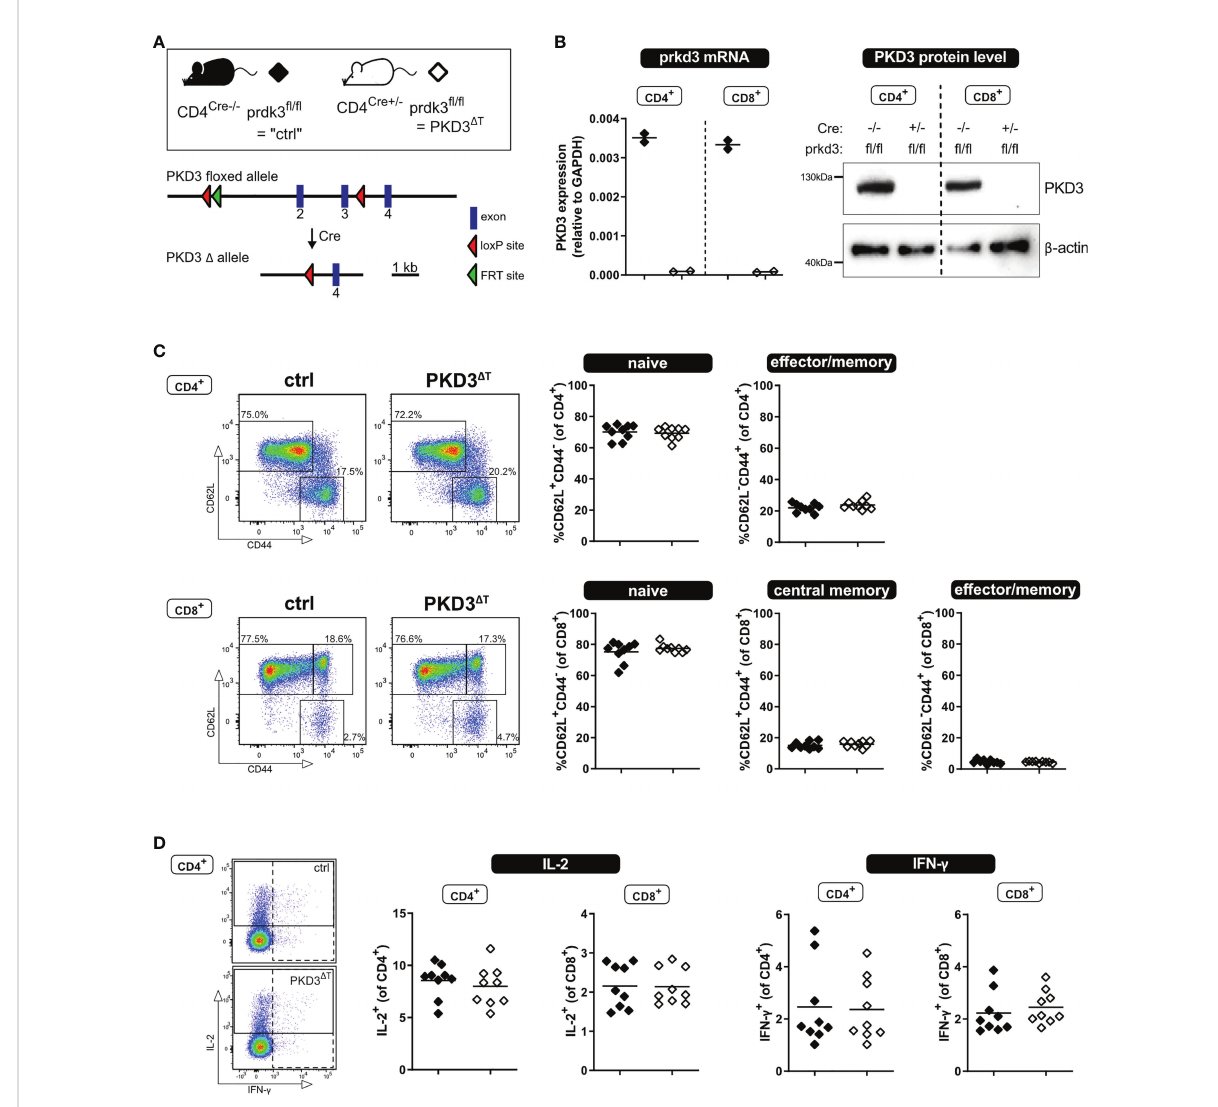
FIGURE 1 T cell-speci fi c PKD3 deletion does not affect the T cell compartment under homeostatic conditions. (A) Scheme of the fl oxed prkd3 locus. (B) Con fi rmation of T cell-speci fi c PKD3-deletion. Ex vivo MACS-sorted CD4 + or CD8 + T cells from spleen and lymph nodes of prkd3- fl oxed mice with or without Cre recombinase were investigated for PKD3 expression on mRNA level by qRT-PCR and on protein level by western blotting. GAPDH and b -actin were used as a house keeping gene or loading control, respectively. (n = 2) (C) Analysis of the splenic T cell compartment of PKD3 D T mice and respective controls by fl ow cytometry. Frequencies of naïve (CD62L + CD44 - ), central memory (CD62L + CD44 + ) and effector/memory (CD62L - CD44 + ) T cells were determined. Representative FACS dot plots (left) as well as summarizing graphs (right) are shown. (n = 9, from two independent experiments) (D) Analysis of cytokine expression: splenocytes from PKD3 D T mice and respective controls were stimulated for 4 h with soluble 5 µg/mL anti-CD3 and 2.5 µg/mL anti-CD28 antibodies. IL-2 and IFN- g were trapped intracellularly with monensin/brefeldin A and analyzed by fl ow cytometry. (n = 9, from two independent